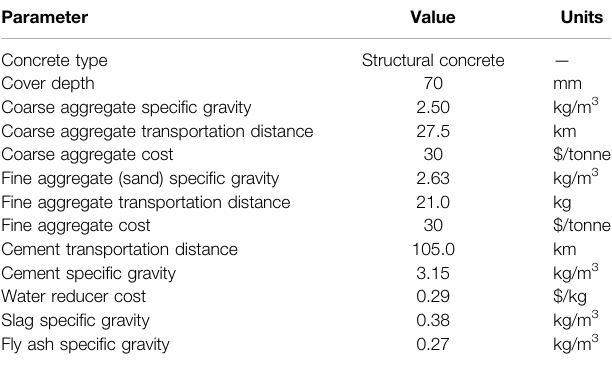
TABLE 4 | Material design parameters (constant throughout case